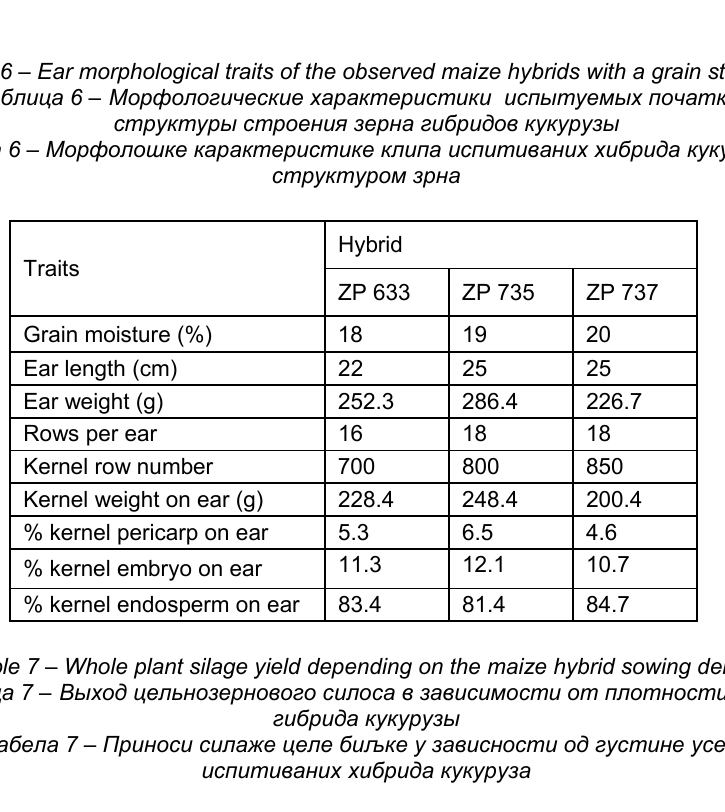
Table 6 – Ear morphological traits of the observed maize hybrids with a grain structure